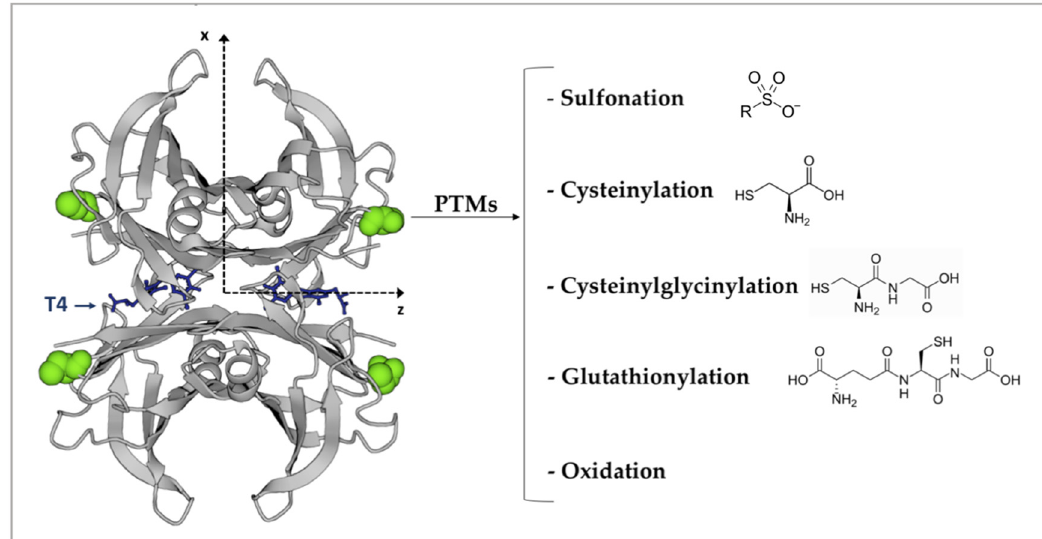
Figure 5. The four Cys 10 are highlighted in green and represented as a spacefill model. The most frequent Cys10 PTMs are indicated on the right. T4 is represented in blue. The figure has been produced by using “www.rcsb.org”web site (protein ID code 1QAB), access date 22 June 2022.